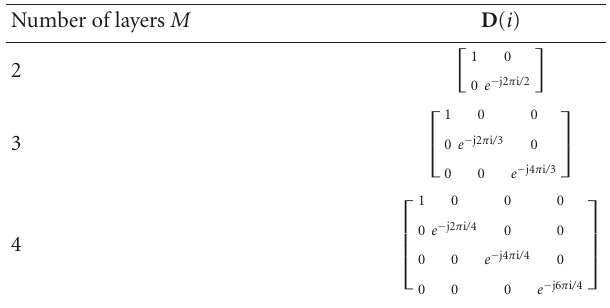
Figure 3: SFBC with two transmit antennas on